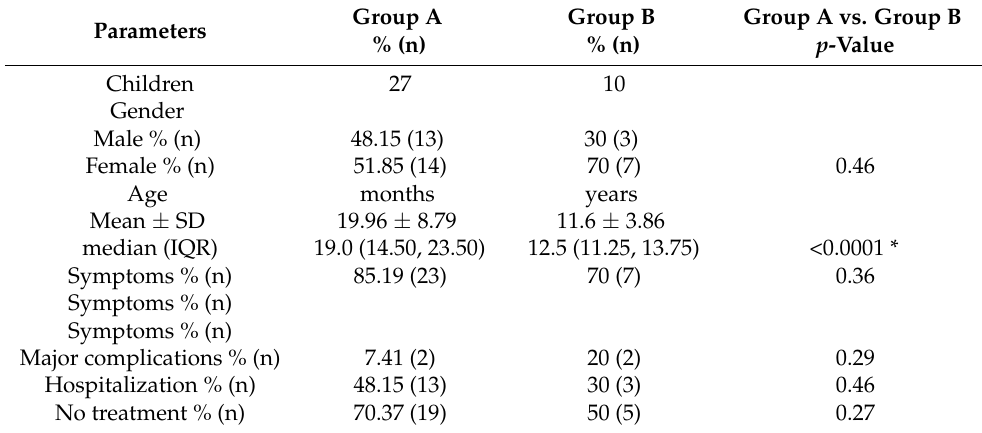
Table 1: the ages of included children ranged between 10 months and 17 years of age. Table 1. Demographic features and characteristics of COVID-19